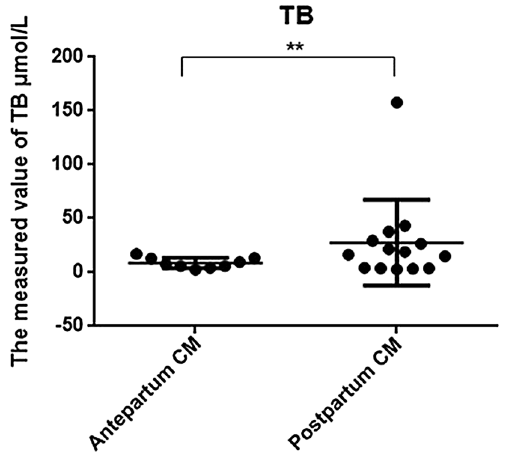
Figure 5. Comparison of liver function using TB between prepartum-diagnosed CM and postpartum- diagnosed CM.